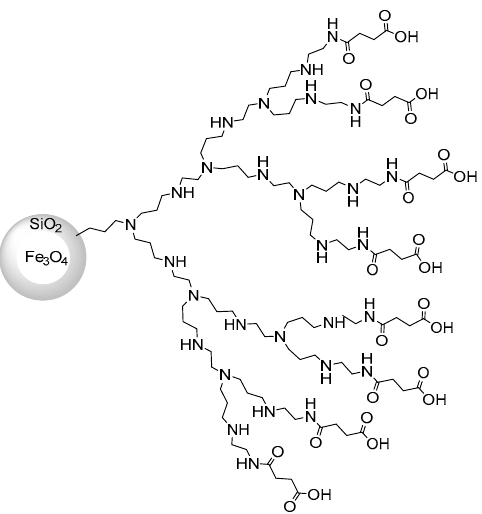
Figure 6. Schematic representation of the Fe 3 O 4 /SiO 2 /PNPEDA G3-COOH